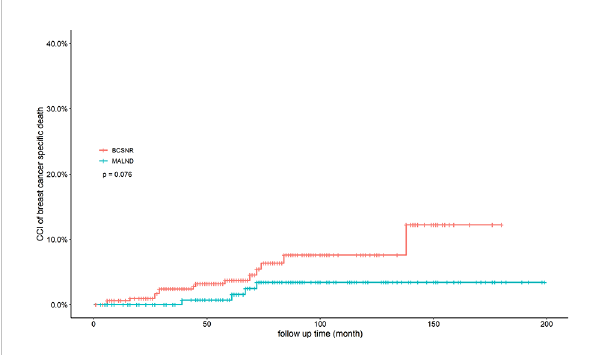
FIGURE 1 Crude cumulative incidence (CCI) of breast cancer speci fi c death for all patients with BCSNR and